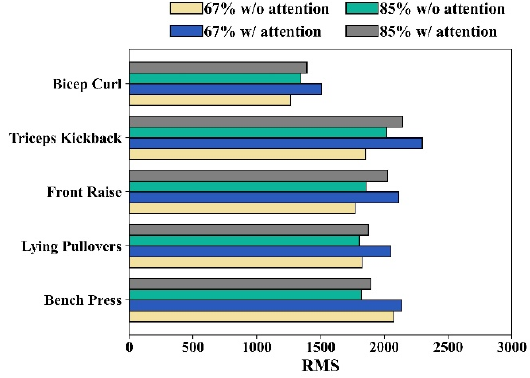
Figure 11. The result of muscle contraction for each exercise in a different attentional focus condition and different lifting weights of